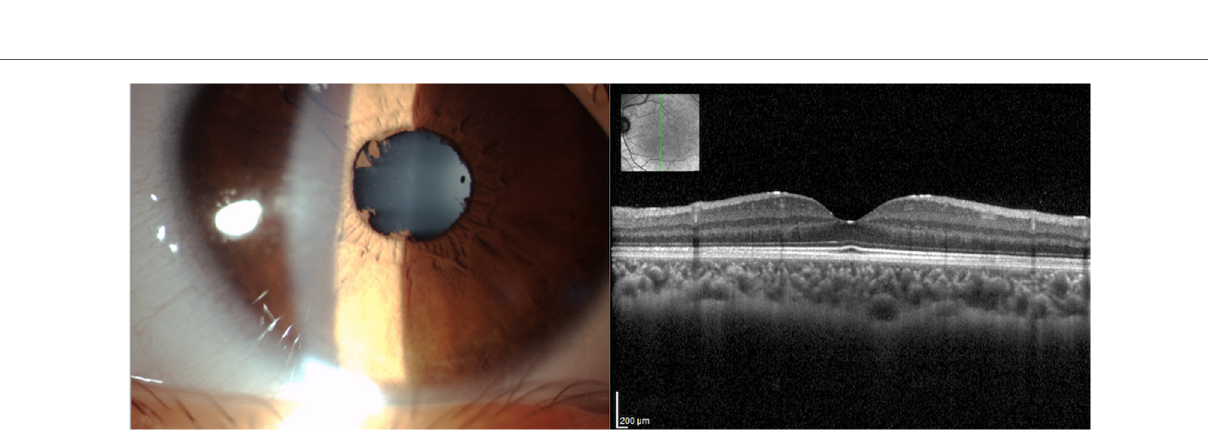
FIGURE 2 Multimodal imaging of the left eye of a 7-year-old boy with Prader – Willi syndrome (case 2). Anterior segment slit-lamp photography (left) showed no granulomatous deposits and posterior synechiae. Spectral-domain optical coherence tomography+infrared re fl ectance (right) displayed macular anatomy and thickness within normal